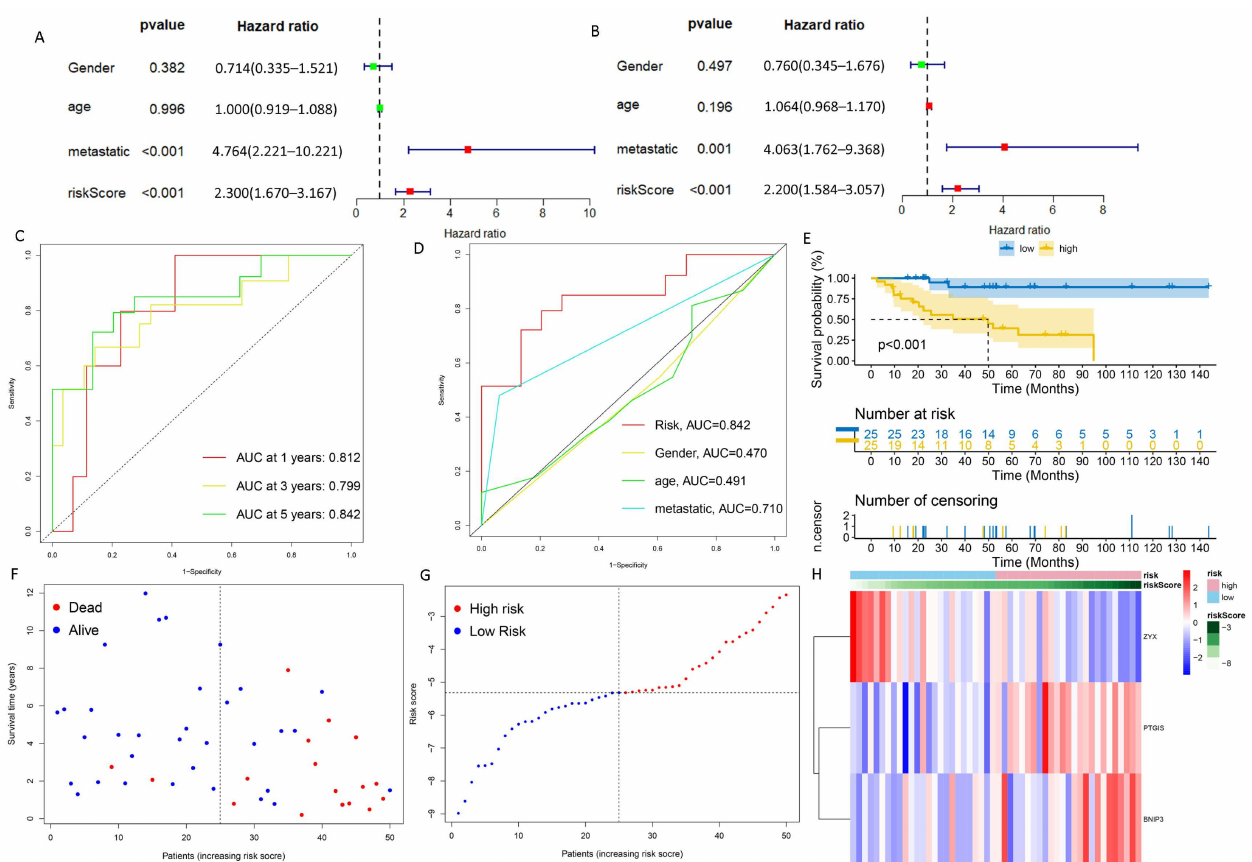
Figure 3. Evaluation of DGPS. ( A ) Univariate Cox analysis. Risk score and metastasis were statistically significant. ( B ) Multivariate Cox analysis. ( C ) ROC curve of DGPS in training group. ( D ) ROC demonstrating that the predictive accuracy of DGPS was superior to the other clinical parameters in the training set. ( E ) Kaplan–Meier curves of overall survival in the training set. ( F , G ) Distribution of risk scores and distribution of overall survival status and risk score in the training set. Blue: low risk; red: high risk. ( H ) Heatmap indicating the expression degrees of BNIP3, PTGIS, and ZYX in the training set. ROC curve, receiver operating characteristics curve; AUC, area under the curve; p < 0.05, statistically